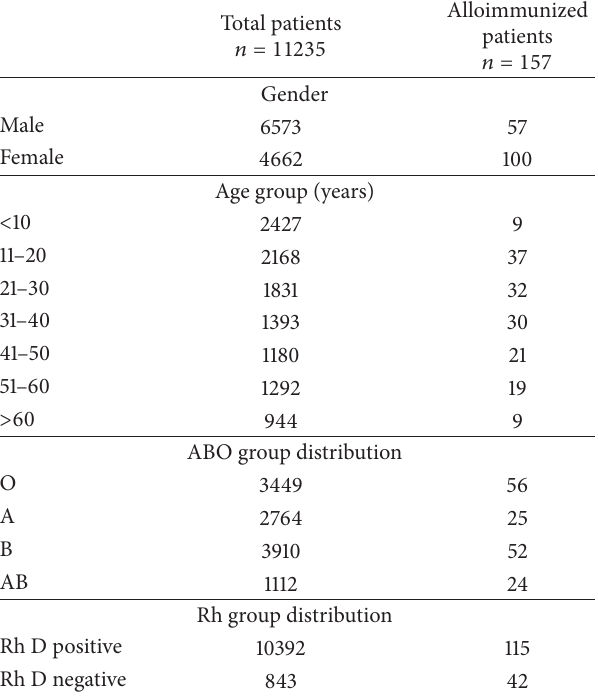
Table 1: Demographic profile of study